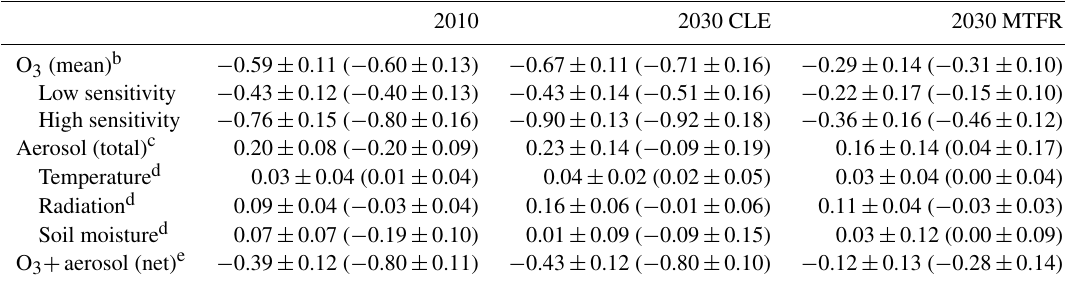
Table 3. Changes in NPP over China due to combined and separate effects a of air pollution (units: PgCyr − 1 ) .